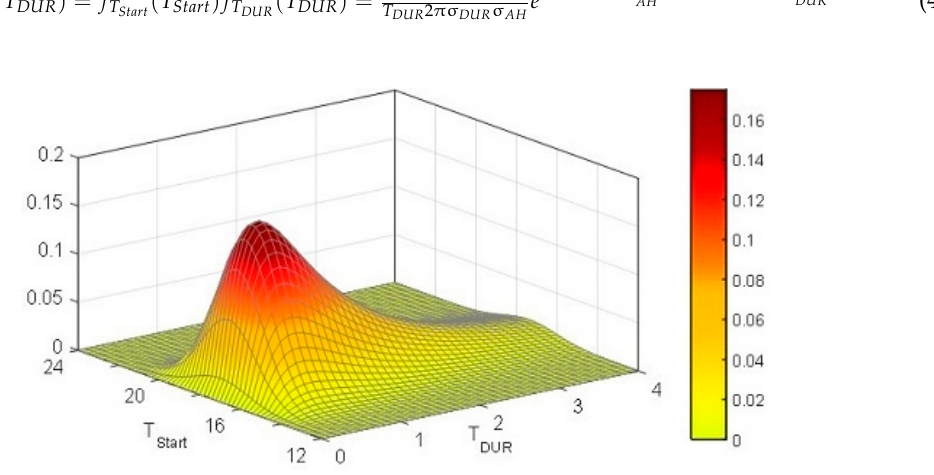
Figure 2. Joint distribution of charging start time and PEV charging duration.